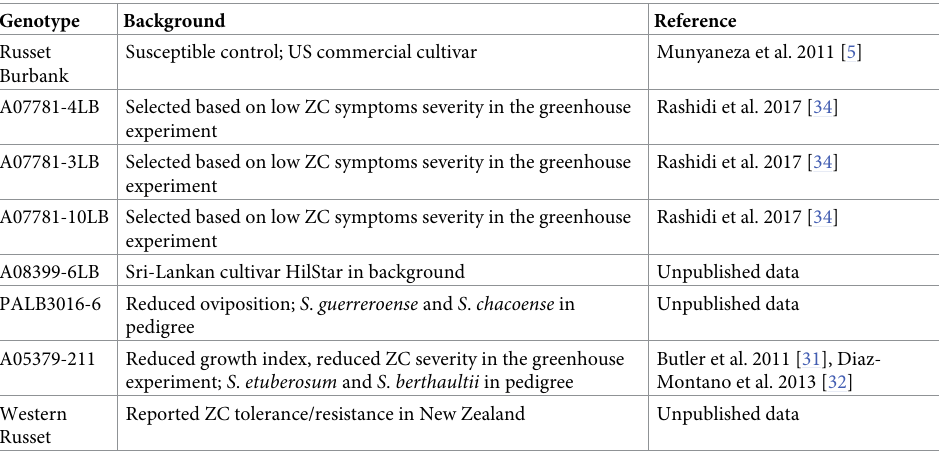
Table 1. Selected potato genotypes for greenhouse, field and storage